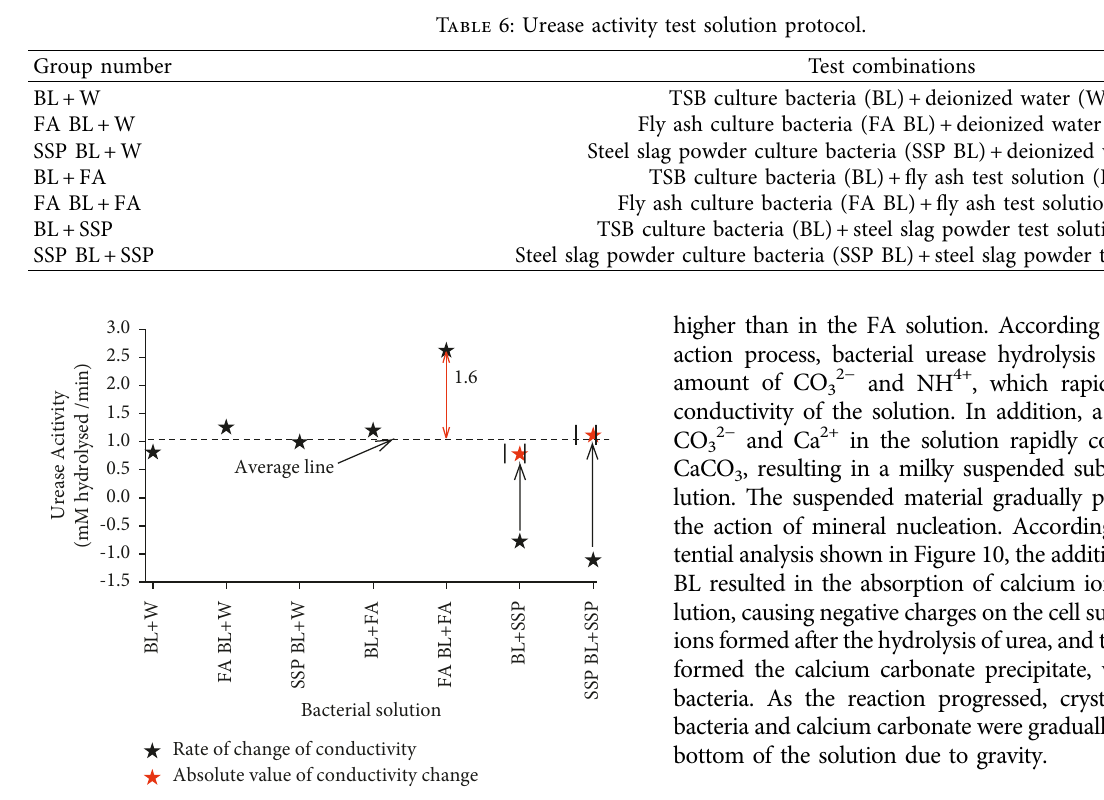
Figure 9: Urease activity distribution map.